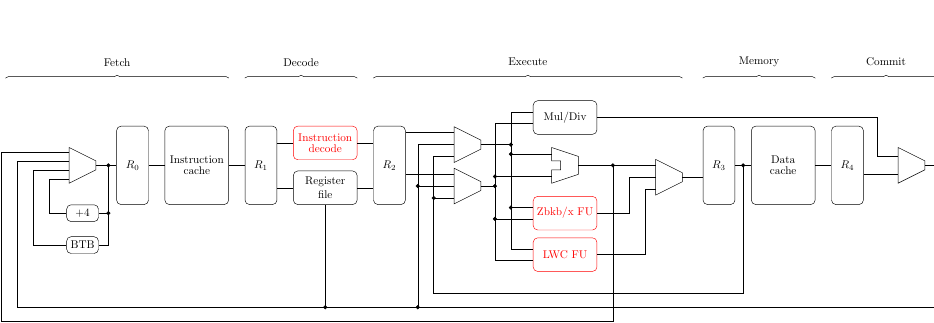
denotes the i -th pipeline i